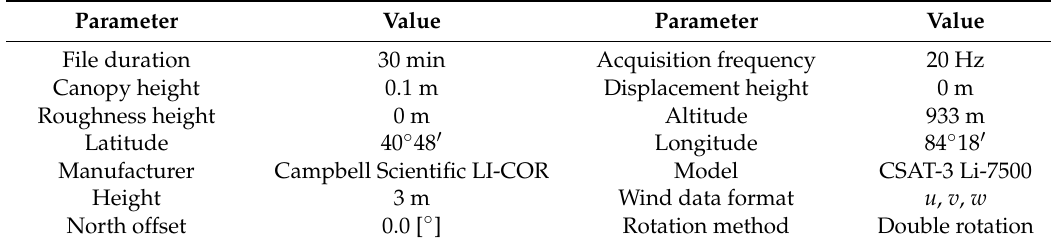
Table 2. EddyPro parameters used in this